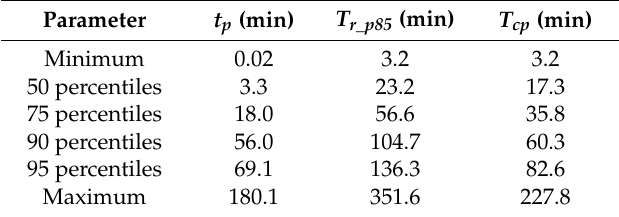
Table 3. Statistical summary of t p , T r_p85 , and T cp of pervious surfaces for 750 modeling cases.